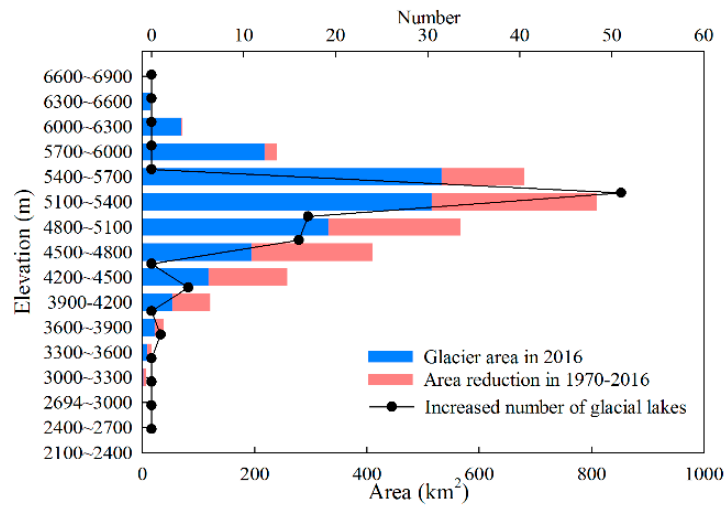
Figure 10. Relationship of glacial recession and the number of glacial lakes with elevation (1970 –